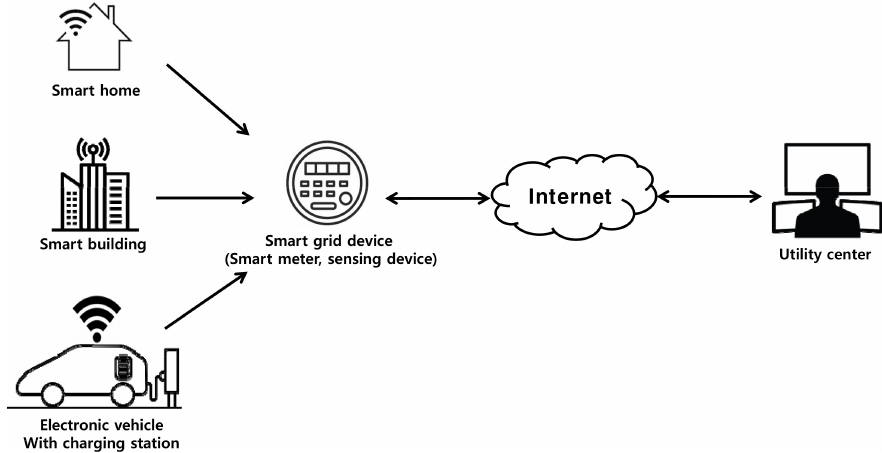
Figure 1. Network model for smart grid environments.